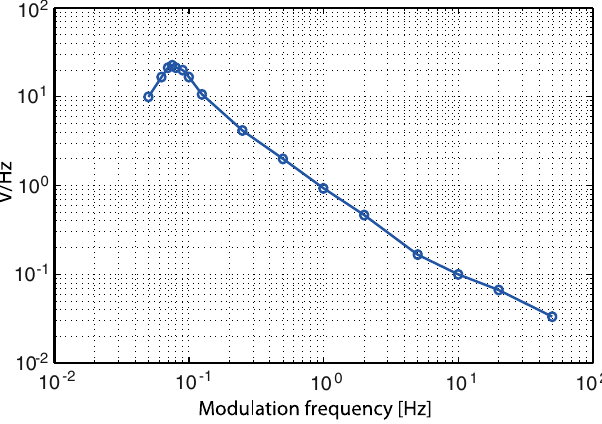
FIG. 2. Conversion efficiency of the mixer as frequency discriminator, measured with the phase-lock loop closed by inserting a signal having a known frequency